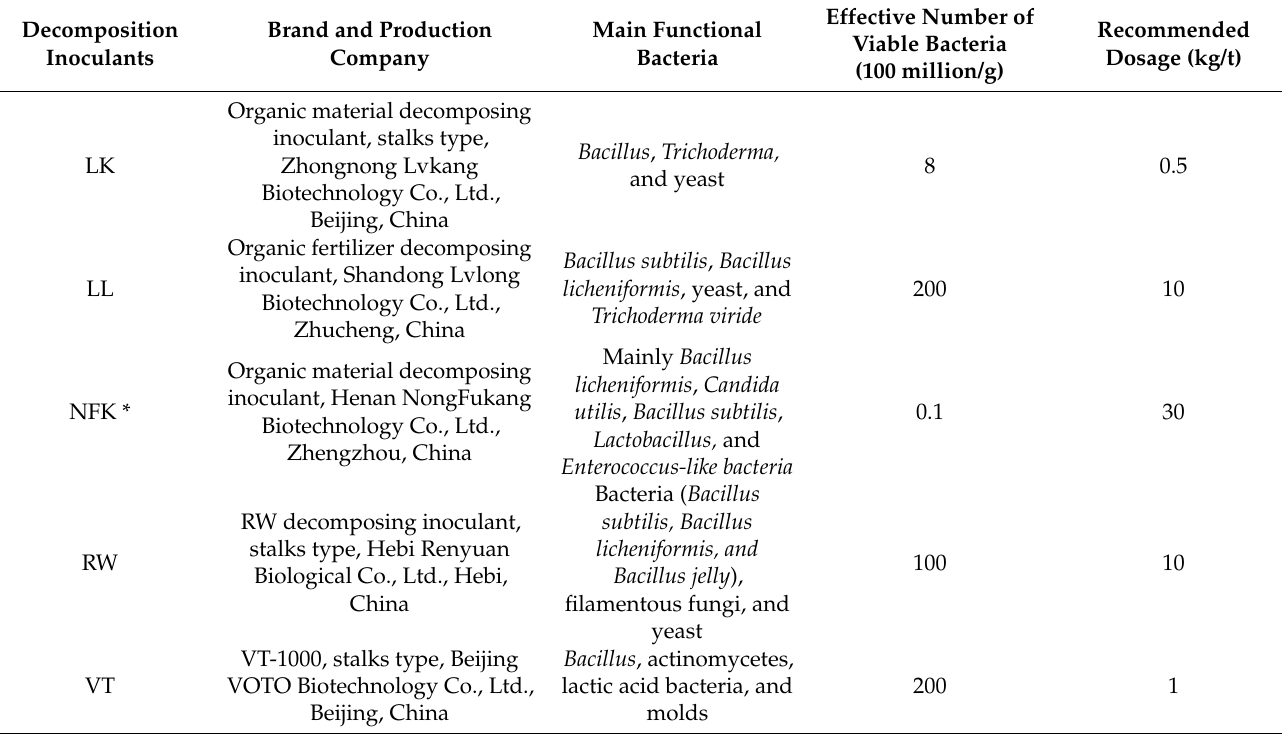
Table 1. Introduction and instructions for decomposition